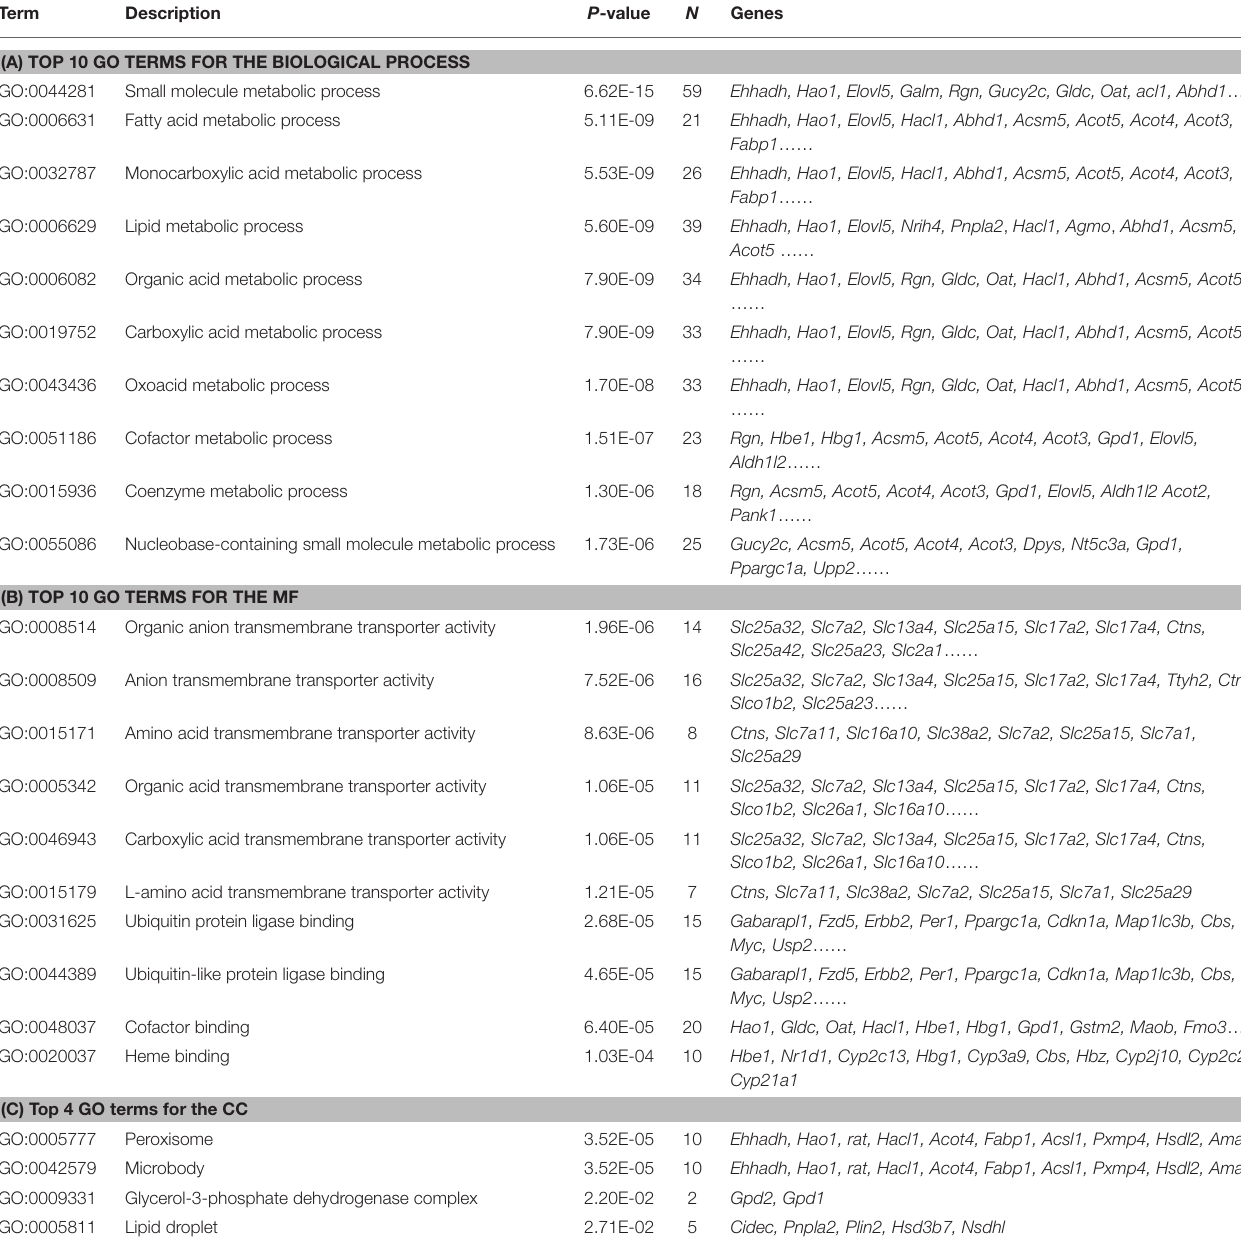
TABLE 2 | The GO terms analysis for DEGs between IUGR and AGA. Term Description P -value N